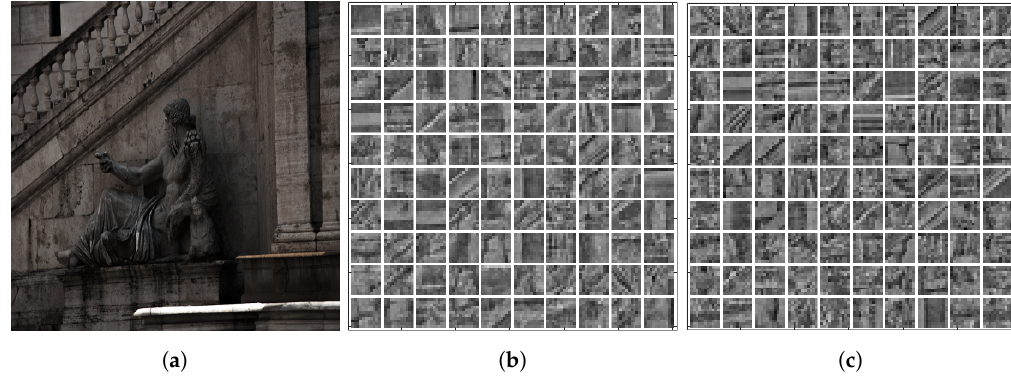
Figure 1. Single image dictionary: ( a ) Training image; ( b ) Sparse coding dictionary in single image [17]; ( c ) CSC dictionary in single image.